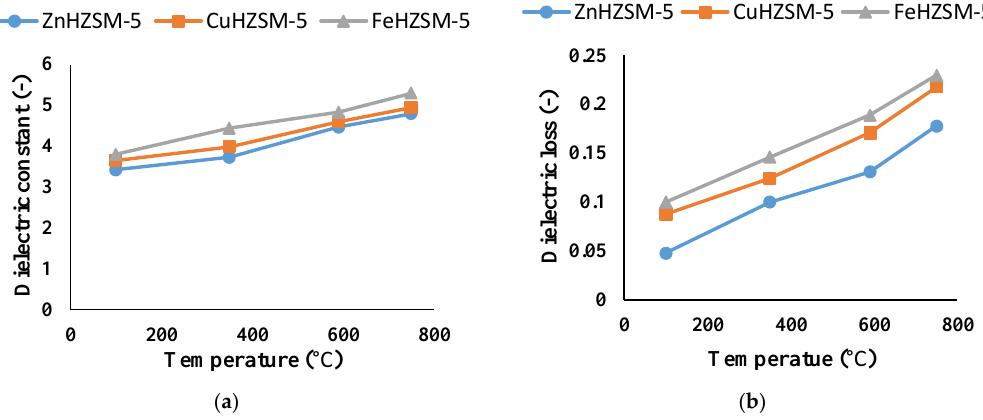
Figure 9. The impedance analysis results: ( a ) Dielectric constant; ( b ) Dielectric loss versus temperature for different catalysts.